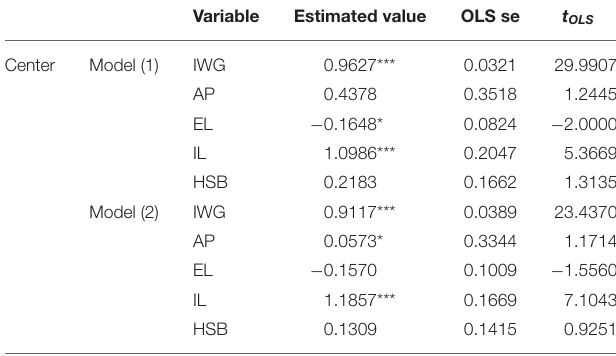
TABLE 3 | Results of the relationship between the two indexes in central China. Variable Estimated value